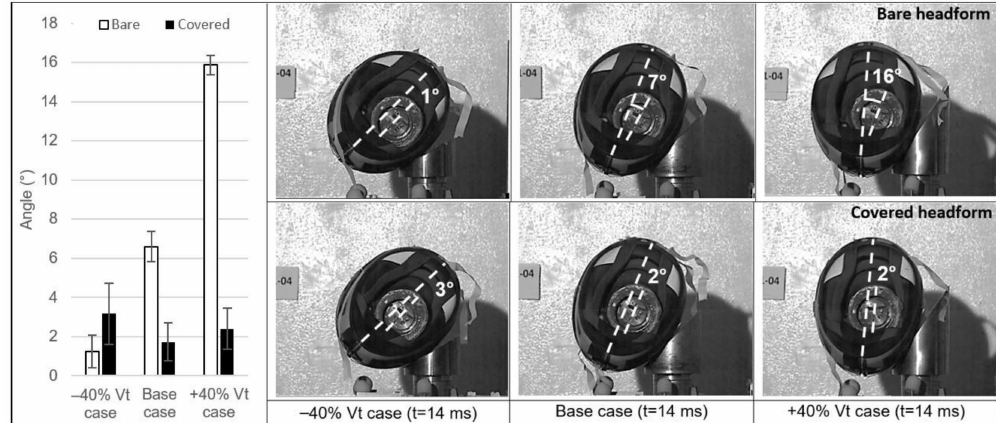
Figure 10. Comparison of the relative motion of the bare and covered headform inside the helmet at 14 ms of the right-side impact. Dashed lines indicate the headform position with respect to the helmet. The angle corresponds to the relative rotation around the Z